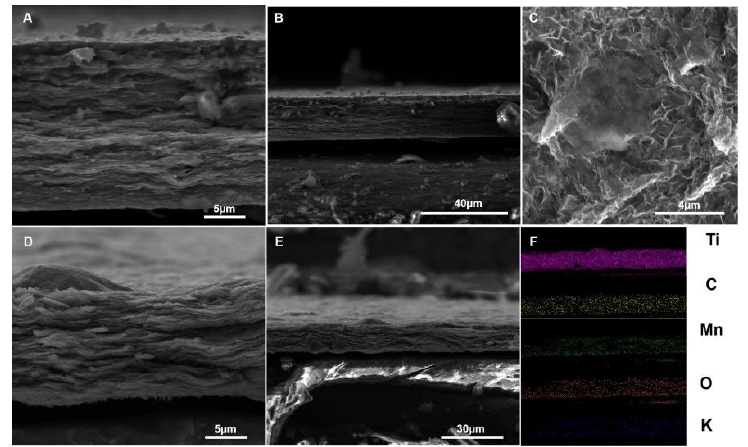
Figure 1. ( A – C ) SEM images of the cross-section and surface of the commercially available MXene solution after suction filtration. ( D , E ) SEM images of the cross-section of the MnO 2 /MXene composite film. ( F ) Element distribution in the MnO 2 /MXene composite film.